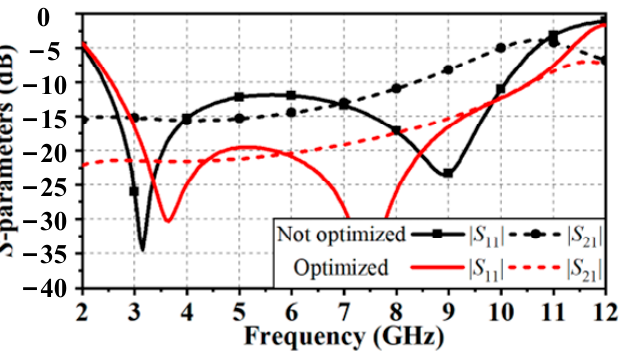
Figure 5. Simulated | S 11 | and | S 21 | of the proposed 3D absorber without the reflecting plate.